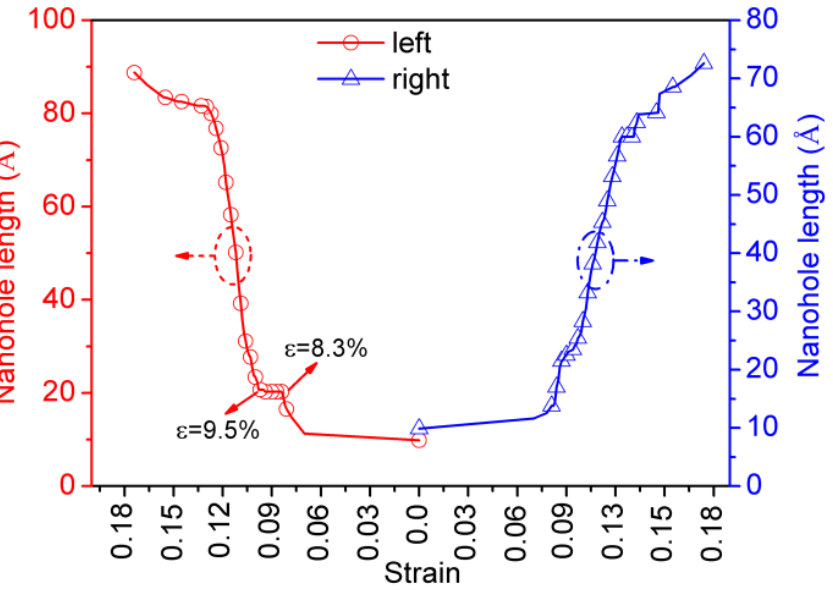
Figure 6. The nanohole length–strain curve of the nanohole propagation process (EAM/FS poten- tial).